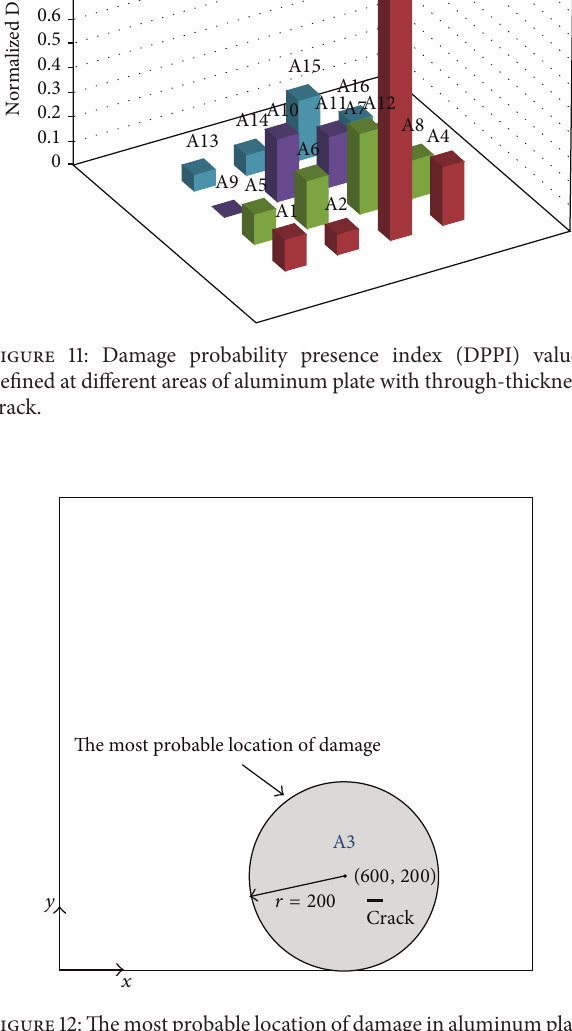
Figure 12: The most probable location of damage in aluminum plate with through-thickness